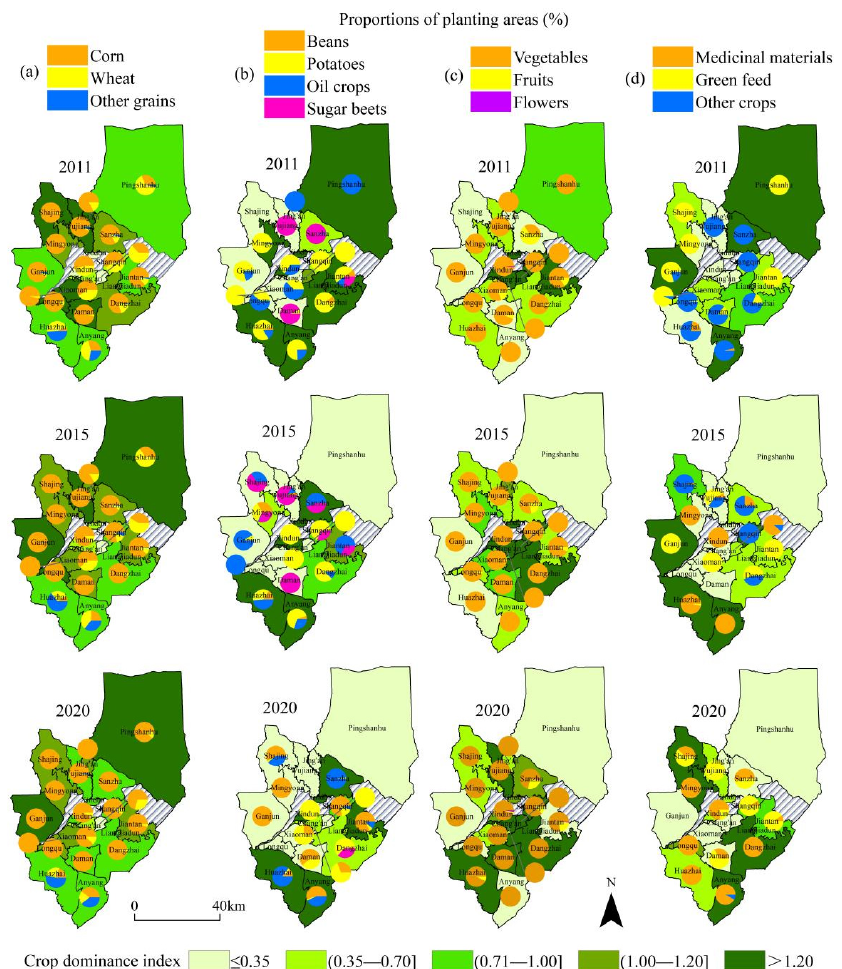
Figure 4. Spatial changes in the dominance of crop planting in townships from 2011 to 2020. ( a ) Proportions of corn,wheat and other grains; ( b ) Proportions of beans,potatoes,oil crops and sugar beets; ( c ) Proportions of vegetables,fruits and flowers; ( d ) Proportions of medicinal materials,green feed and other